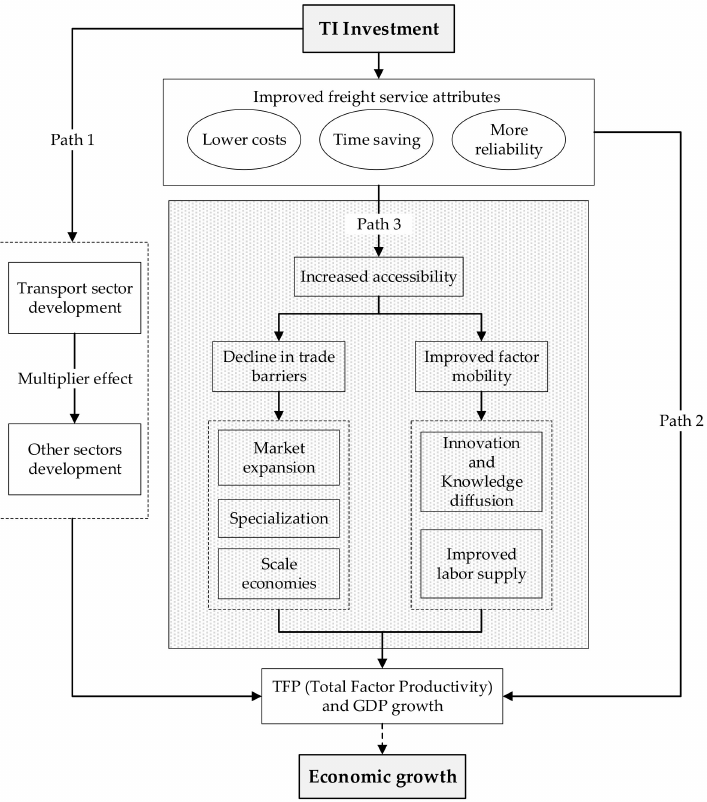
Figure 1. Impacts of TI investment on economic growth. Note: Path 1—multiplier effect; Path 2—cost- saving effect; Path 3—wider economic impacts (WEI). Note: → direct influence; (cid:57)(cid:57)(cid:75) potential influence. Another aspect of WEI lies in the advancement of factor mobility (i.g., capital,